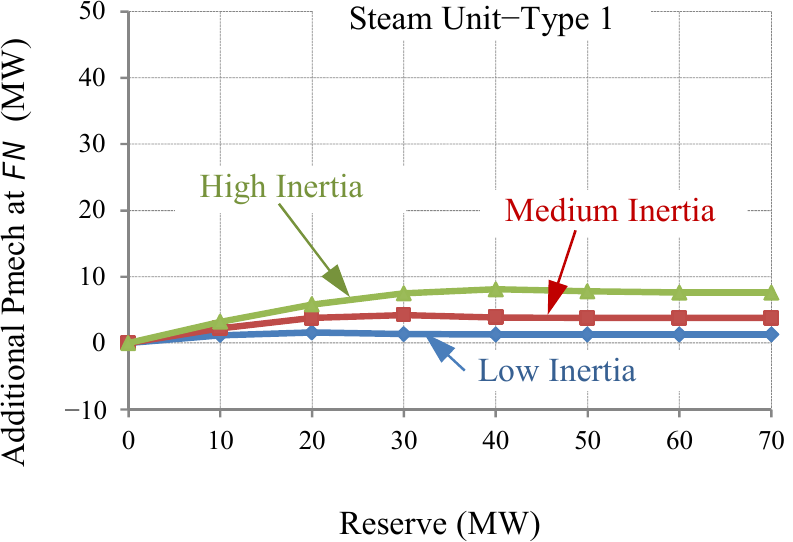
Figure 4. Additional mechanical power of Steam Unit—Type 1 as response for 350 MW trip, in 3 inertia conditions.